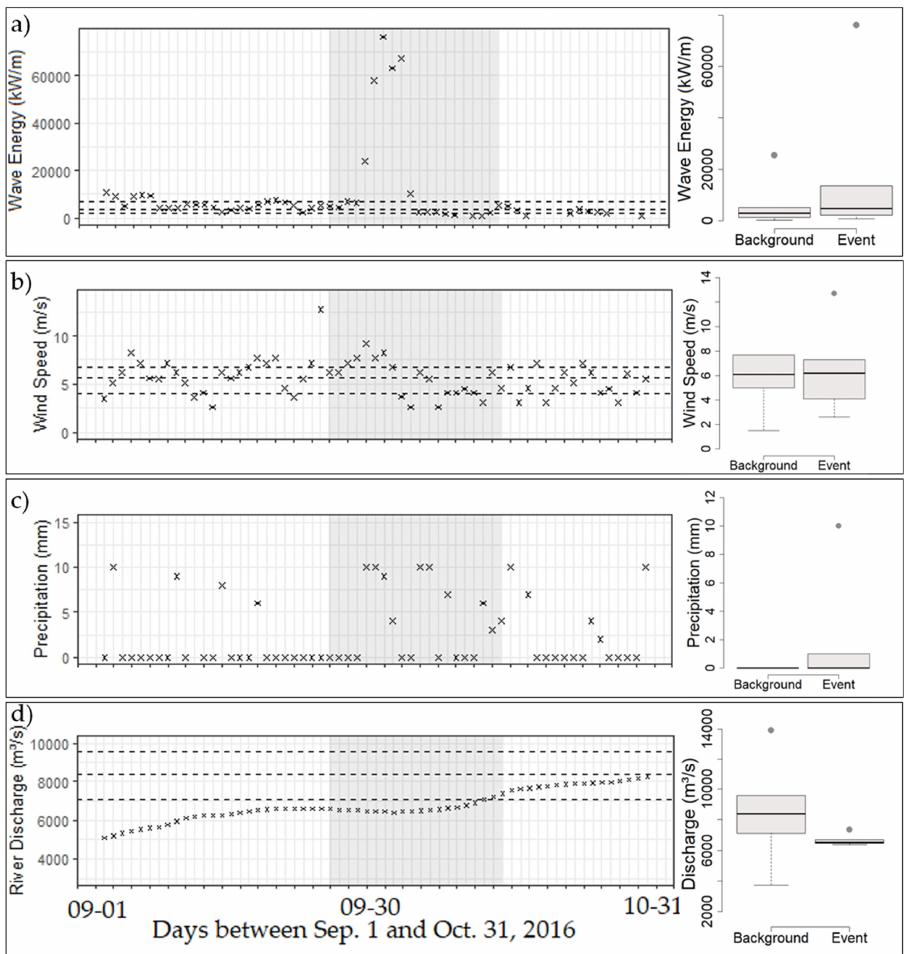
Figure 11. Time series of potential drivers of a lagoon breaching in September–October 2016. The left panels indicate daily maximums for ( a ) wave energy, ( b ) wind speed, ( c ) precipitation, and ( d ) the Magdalena River discharge. Dashed lines show the 25th, 50th, and 75th percentiles of an average non-event (background), and crosses indicate the conditions before, during (grey shaded area), and after the event. Box plots on the right panels help visualize DBM/OVS ratios reported in Table 1.